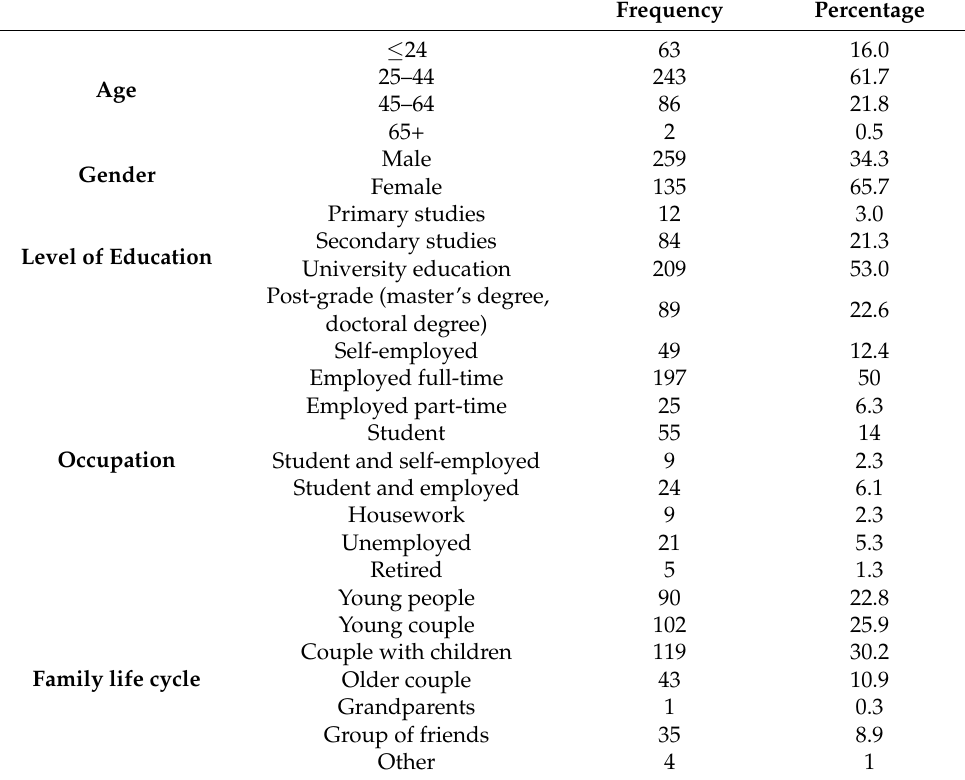
Table 1. Respondent